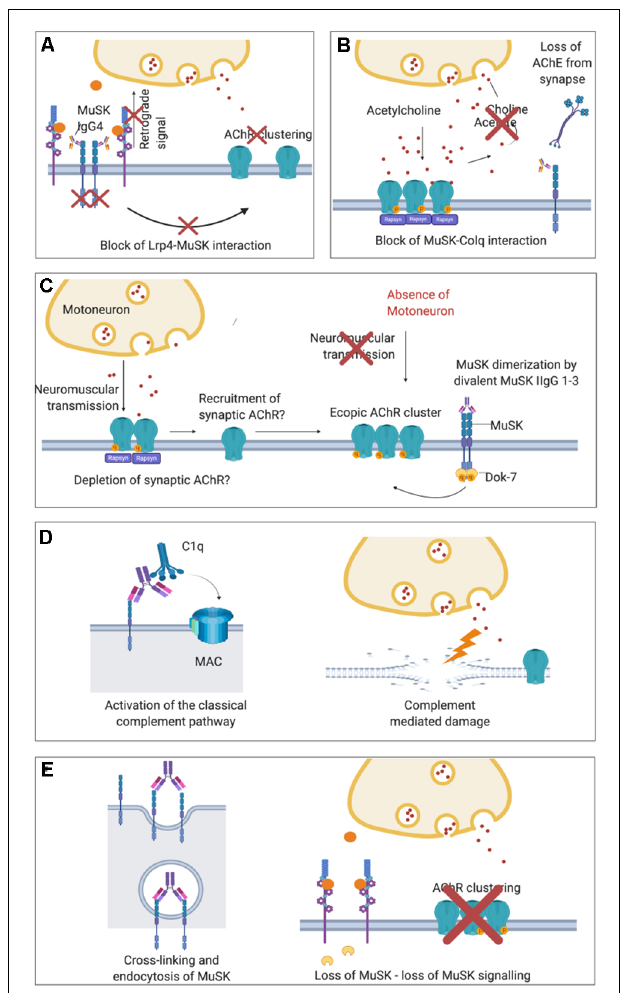
FIGURE 4 | Proposed pathological mechanisms of MuSK autoantibodies at the NMJ. (A) In MuSK-MG, autoantibodies of the IgG4 subclass bind to the ectodomain of MuSK preventing its interaction with LRP4 and therefore block down-stream signaling. The phosphorylation cascade is therefore inhibited causing the ultimate dispersal of AChR clusters. Loss of retrograde signaling mediated by LRP4 may also explain the absence of presynaptic adaptive increase of ACh vesicles observed in MuSK-MG animal models which are otherwise characteristic in AChR-MG. (B) Block of ColQ-MuSK binding by MuSK autoantibodies has been proposed to be a pathogenic mechanism that may lead to a loss of AChE from the ECM at the NMJ. (C) Divalent binding of commercial or cloned (monospecific) MuSK antibodies has been proposed to cause MuSK dimerization and activation, leading to ectopic, extra-synaptic AChR clusters. These would not participate in neuromuscular transmission as they would lack adjacent motoneuron terminals. For the formation of ectopic AChR clusters, AChR may also be recruited from synapses thus depleting the NMJ from AChR. (D) In vivo MuSK antibodies (IgG1–3) may recruit C1q and activate the classical complement pathway, causing complement-mediated damage at the NMJ. (E) MuSK antibodies could also cross-link MuSK and lead to increased internalization of MuSK, thus effectively depleting MuSK from the muscle membrane and cause a loss of agrin-LRP4-MuSK-DOK7 signal